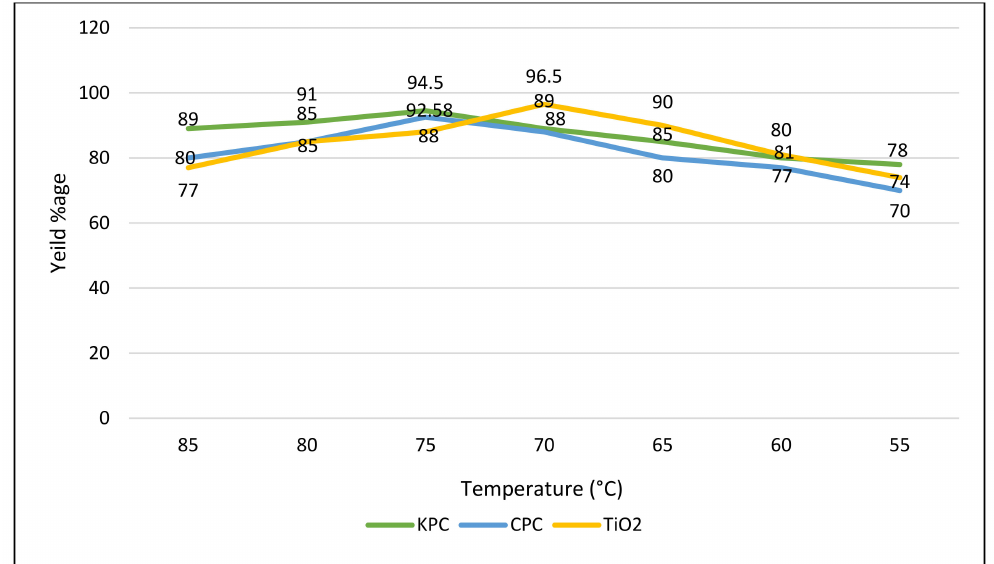
Figure 26. Temperature effect on transesterification, while other variables (catalyst amount, time period) were kept constant.